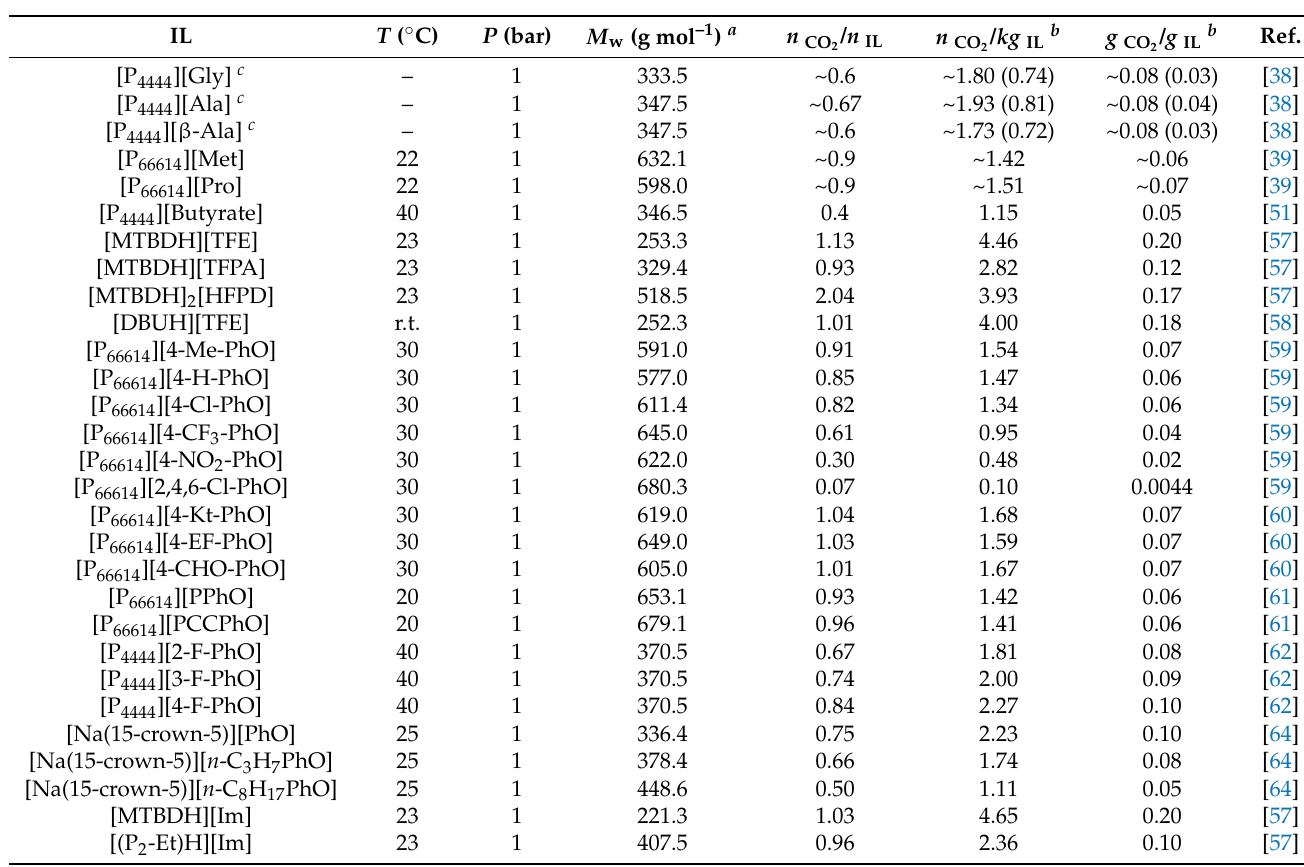
Table 2. Typical anion-functionalized ILs for CO 2 capture via single-site mechanisms.